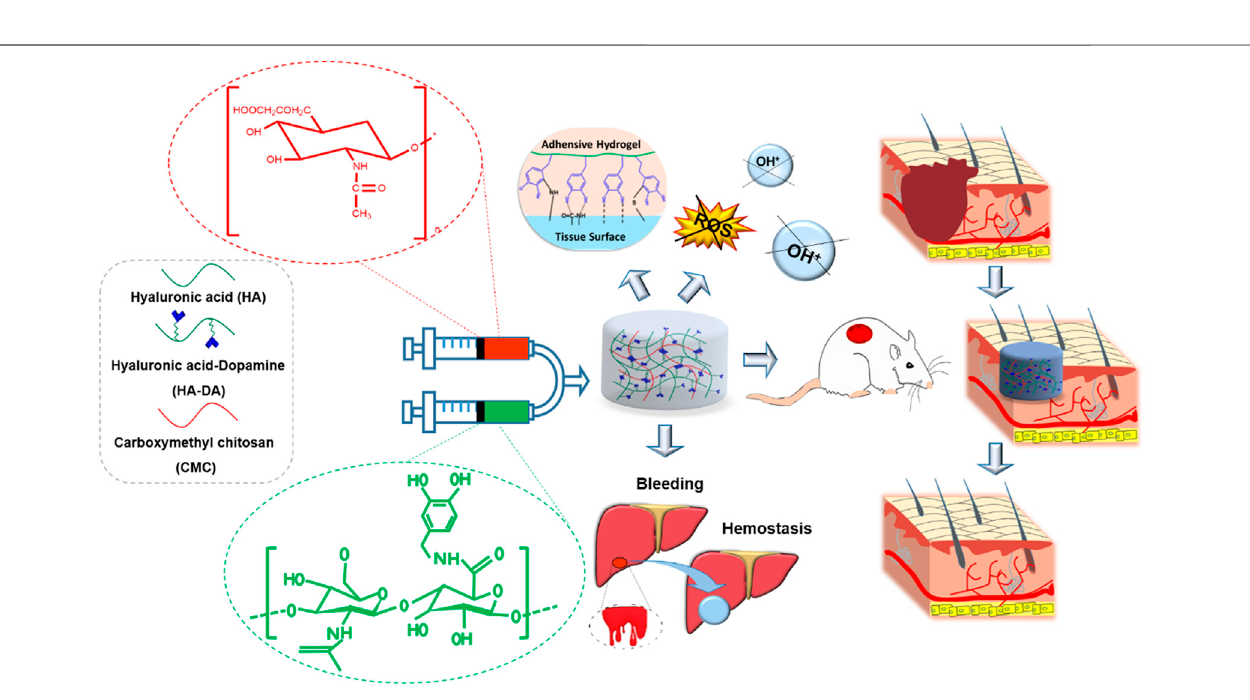
Frontiers in Bioengineering and Biotechnology |